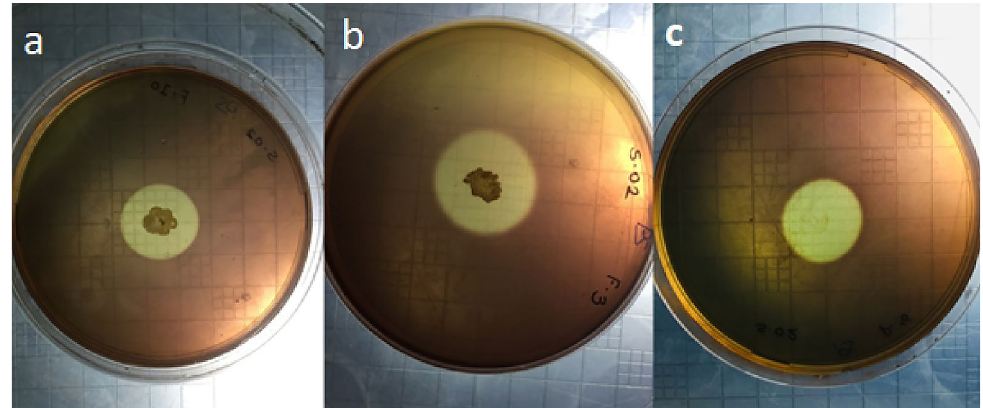
Figure 1. Zone of Pectin hydrolysis on PSP agar medium of isolate ( a ) Bacillus licheniformis PKC4, Centre ( b ) Bacillus subtilis PKC2, ( c ) Paenibacillus lactis PKC5 after Gram’s iodine staining.